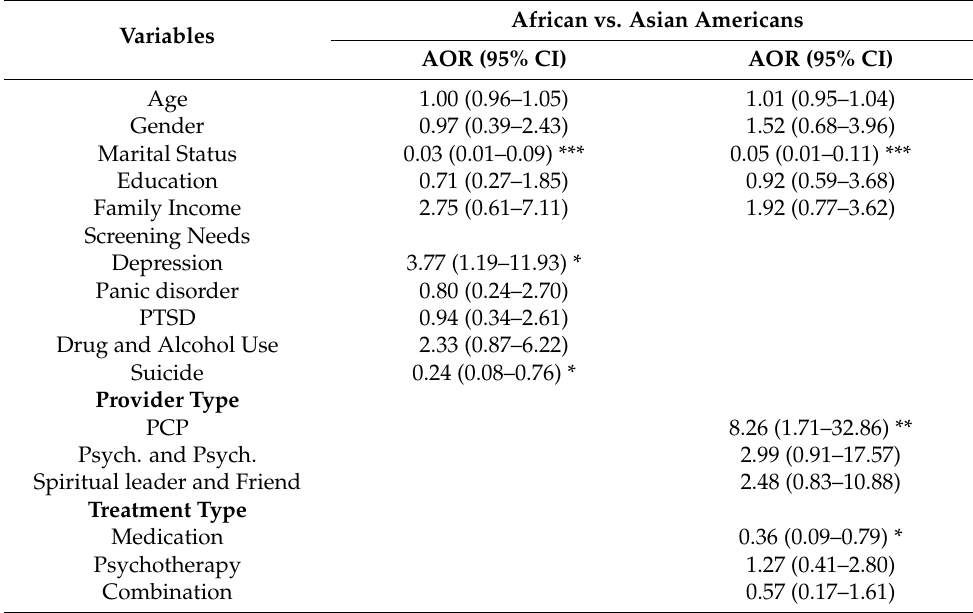
Table 2. Ethnic differences in screening needs and mental health treatment and provider